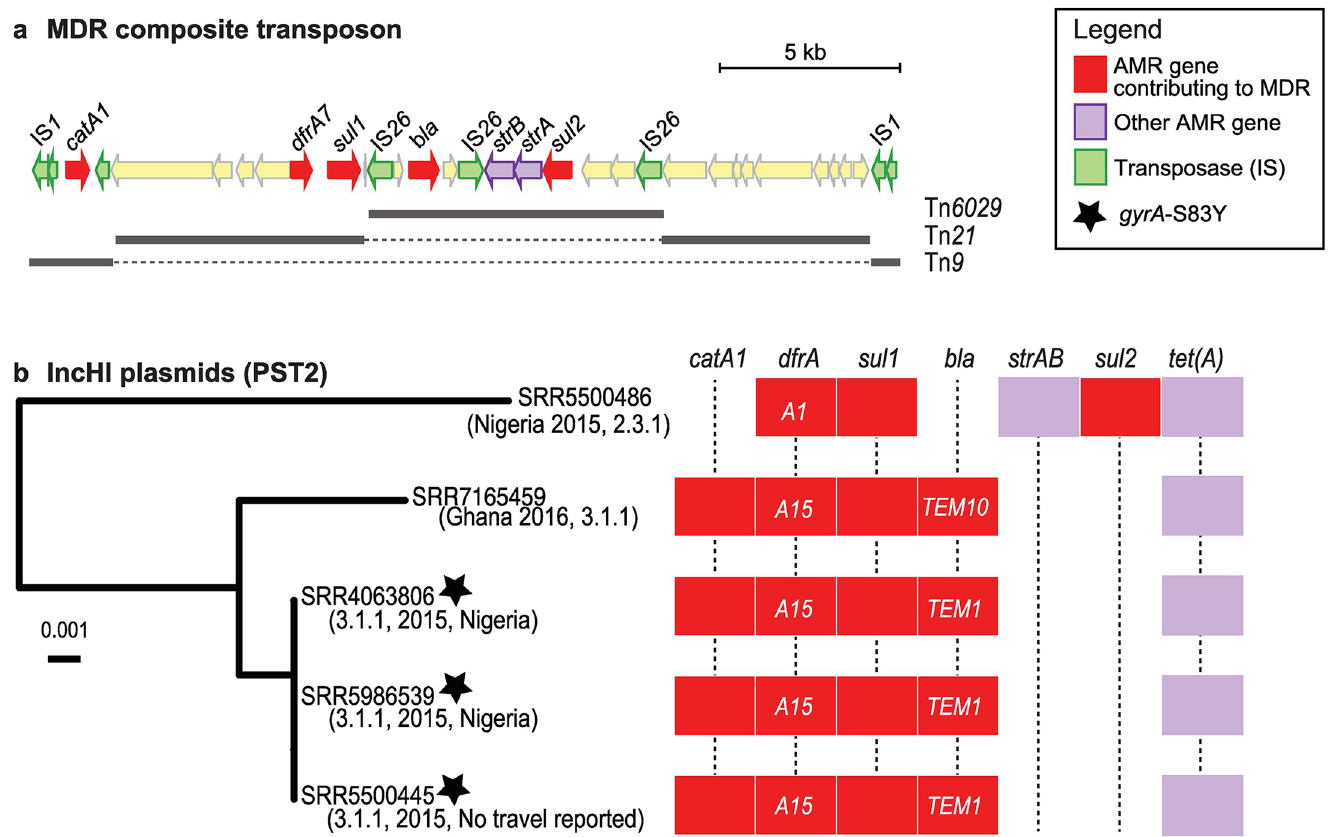
Fig 5. Mobilisation of MDR element in S . Typhi. a) Structure of the MDR composite transposon in S . Typhi strain ERL12960 (4.3.1 lineage I) is shown (accession ERL12960). MDR genes are those encoding resistance to the first line drugs ampicillin, trimethoprim-sulfamethoxazole or chloramphenicol b) Phylogeny showing genetic relationships between the five IncHI1 PST2 S . Typhi isolates identified in this study, based on SNVs identified in the plasmid backbone sequence and rooted using the PST1 plasmid pUI1203_01 (accession ERR340785) as an outgroup. The presence of AMR genes detected in each genome is indicated in the heatmap, with alleles specified for dfrA and bla TEM